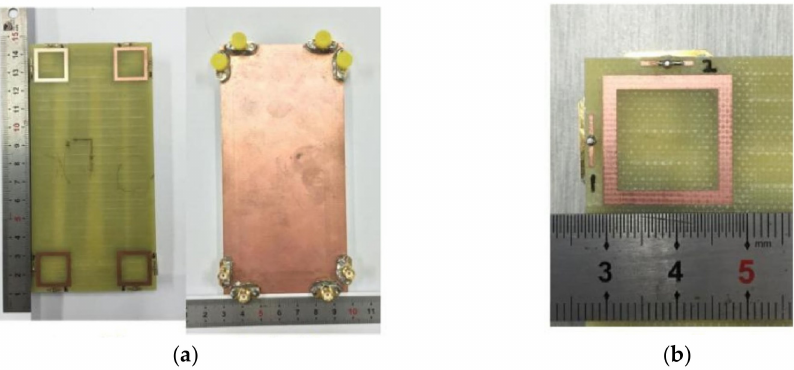
Figure 6. MIMO antenna with orthogonal polarization: ( a ) geometry of proposed MIMO; and ( b ) antenna element with dual-polarized modes (Results from